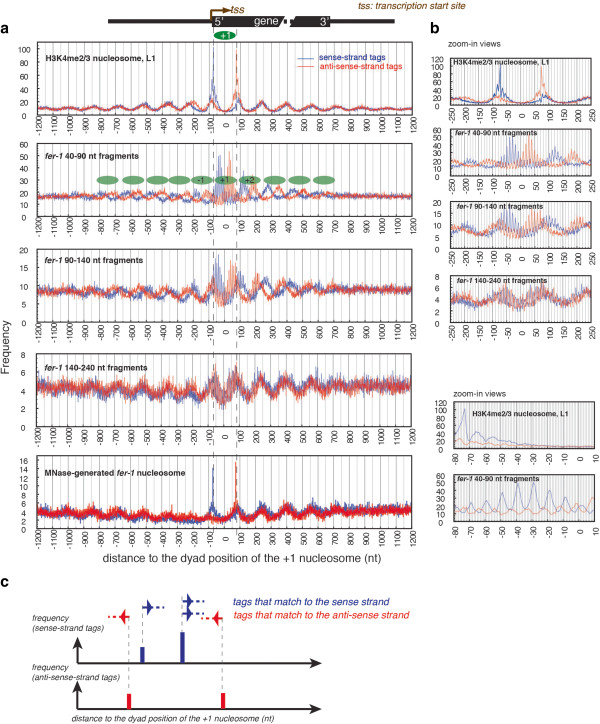
Endo-cleavage profiles at the 5′ ends of genes for the activated oocyte chromatin. (a) The number of tags was plotted as a function of distance to the dyad of the 'plus-one’ nucleosome, defined by peak H3K4me2/3 nucleosomes near transcription start sites for the 3903 'H3K4me2/3-anchored’ genes [20]. Tags that mapped to sense-strand and anti-sense-strand were plotted separately. A set of nucleosome cores are indicated by ovals (scaled to indicate a size of 147 nt). To contrast short and longer-scale periodicities, several expanded views are plotted in panel (b). (c) A schematic diagram showing the analysis.